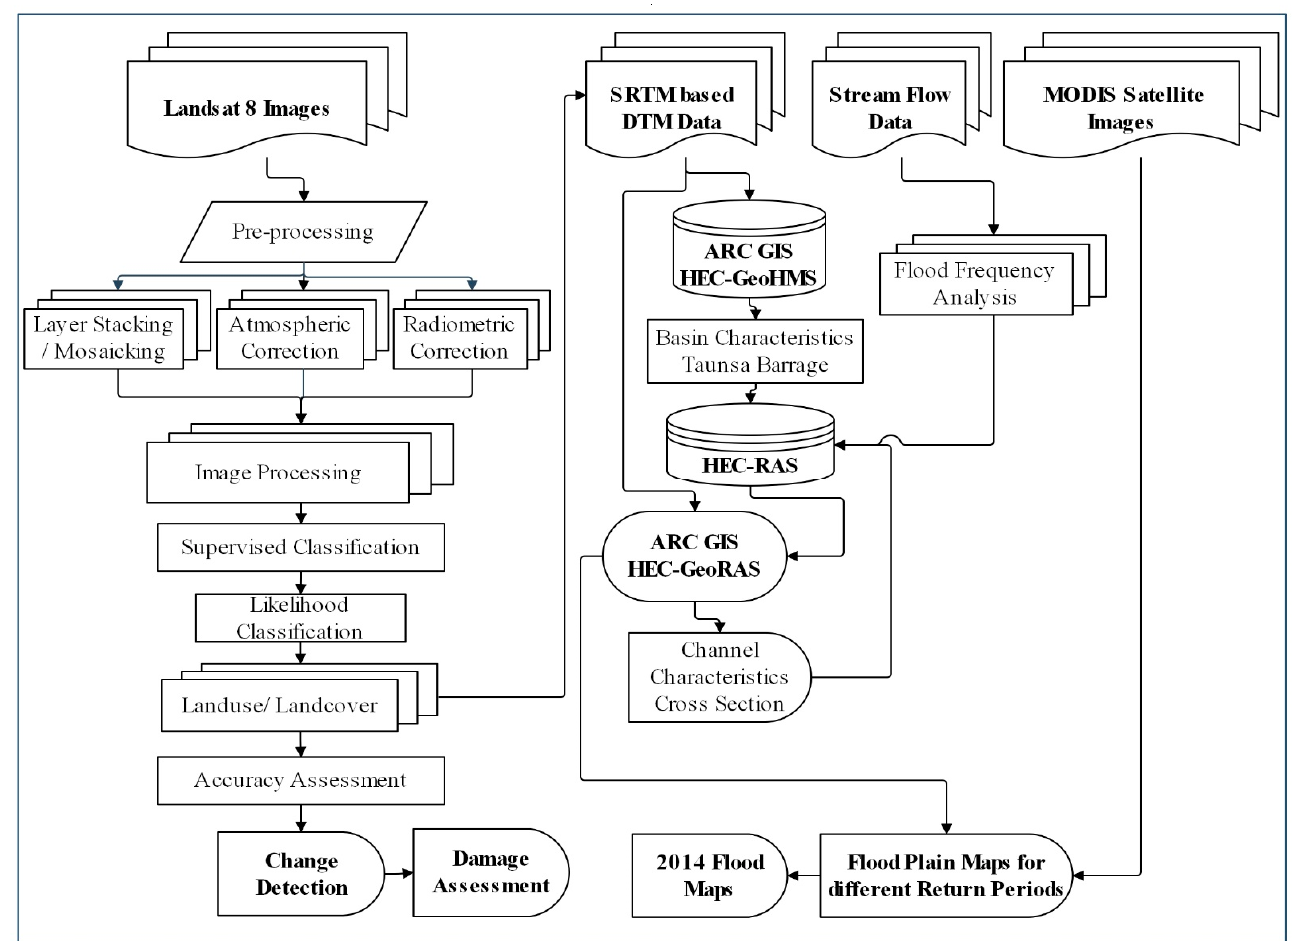
Figure 2. Schematic representation of the methodological approach used in this study .